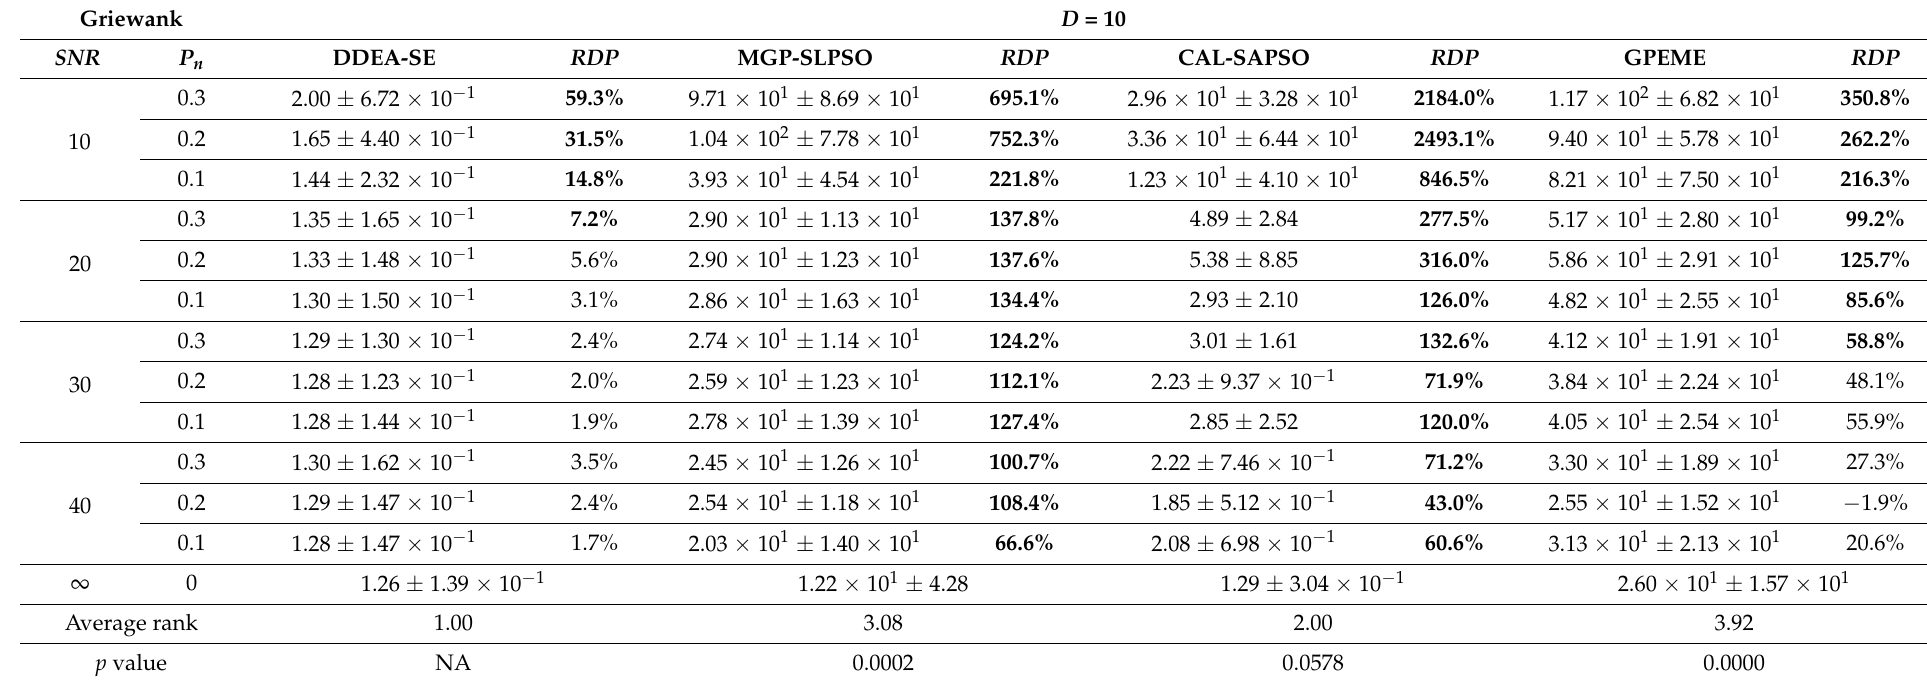
Table A7. Experimental results (with standard deviation) and RDP of DDEAs on 10-dimensional Griewank problems. Griewank